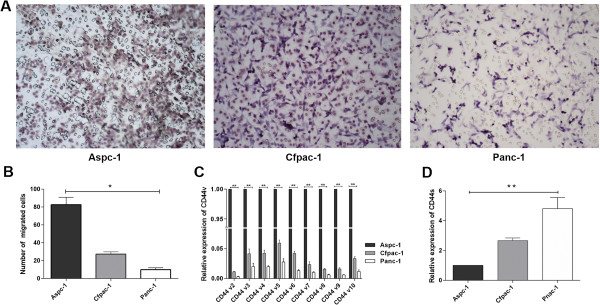
Invasion capacities and CD44 expression levels of Aspc-1, Cfpac-1 and Panc-1. A-B Tumor cell invasion activities were measured using a transwell assay. Representative image fields of invasive cells on the membrane are shown. C-D Expression levels of CD44v and CD44s in three PCa cell lines.